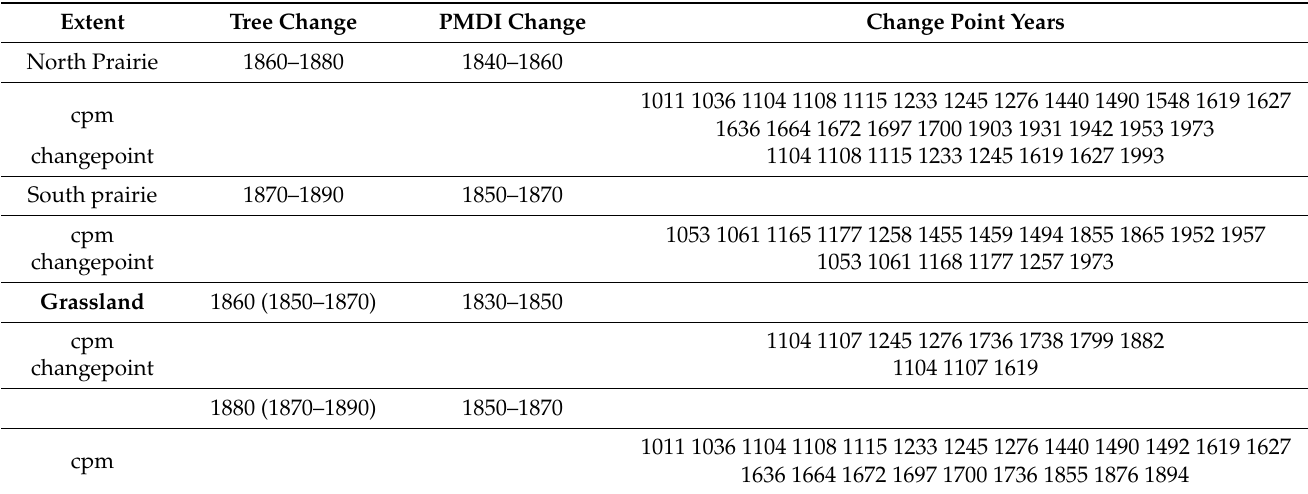
Figure 5. The PMDI values for quarter-century interval box plots during years 1000 to 2000 (101 equals first quarter-century of the 1000s) and all PMDI values during years 1700 to 1950 with a fitted line and 95% confidence intervals for the northern (251) and southern (255) prairie provinces. Table 3. Approximate decades of tree change in density and diversity and expected preceding change in Palmer Modified Drought Index (PMDI) and sequential change point detection (with two methods) for two prairie provinces and for grassland and forest areas after reaching the threshold of 25%